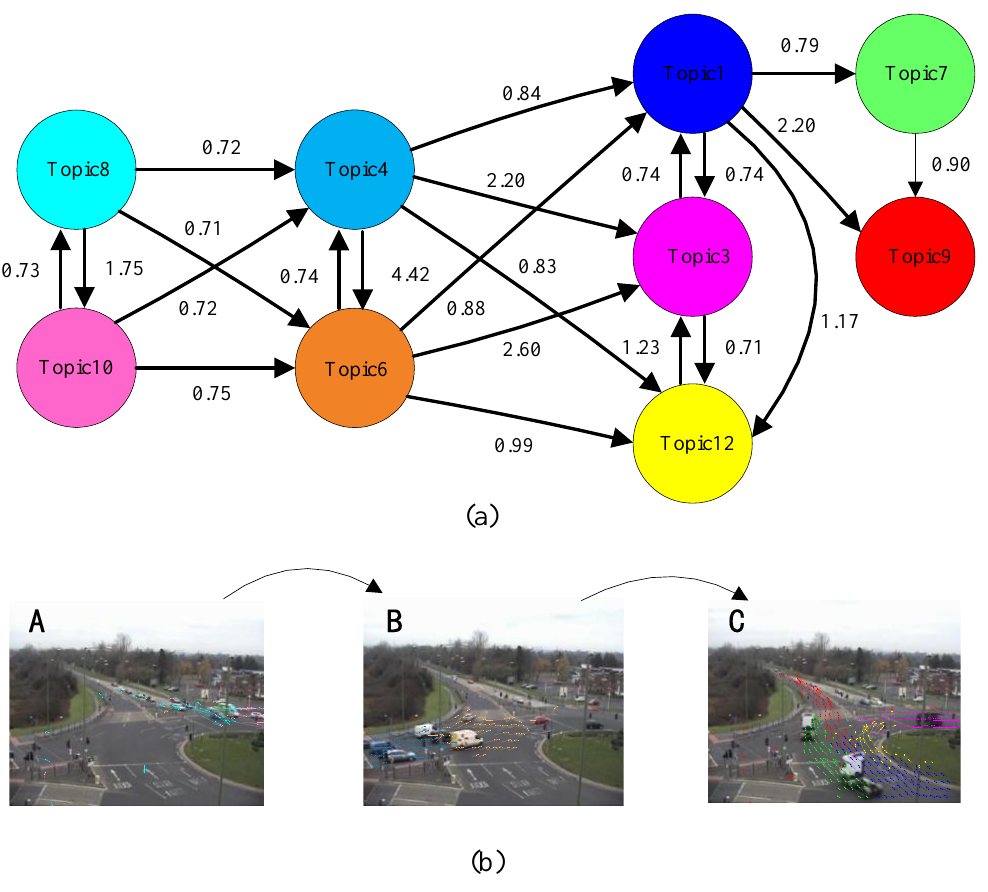
Figure 10. Granger causality approach applied to the roundabout dataset. ( a ) Top: visualization of the temporal causal analysis; ( b ) Bottom: a scene with traffic lights. Three states are automatically